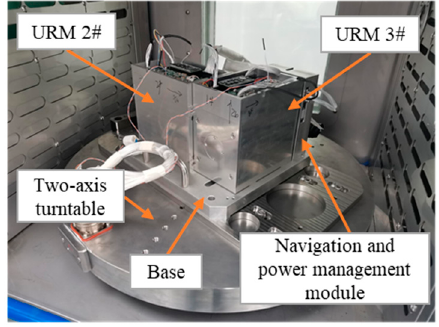
Figure 10. A prototype is used in the experiment. Table 5. Parameters of the two ‐ axis